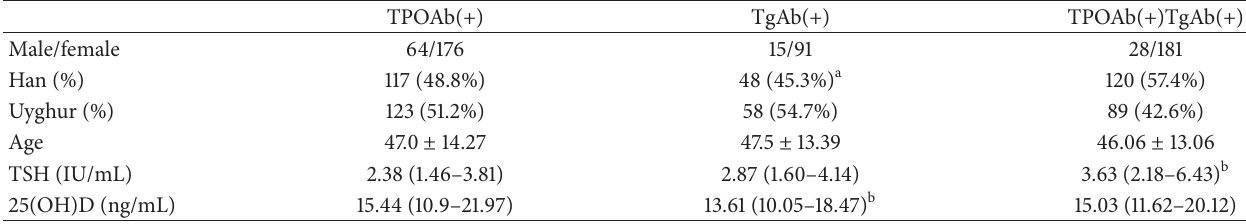
Table 2: Comparison of clinical and laboratory characteristics based on the positivity of serum antibodies.